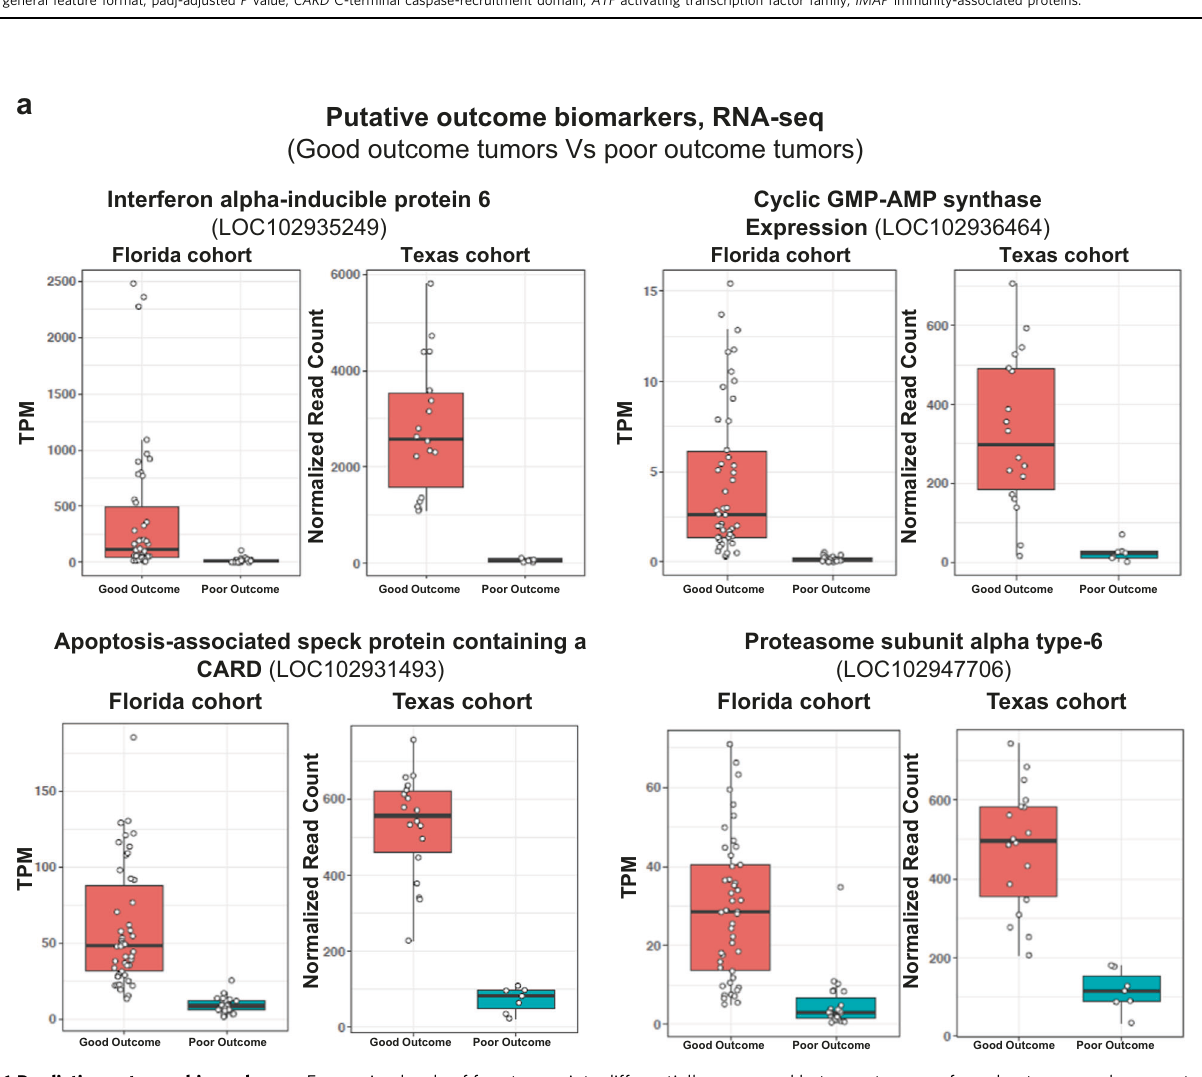
Fig. 6 Predictive outcome biomarkers. a Expression levels of four transcripts differentially expressed between tumors of good outcome and poor-outcome patients, as detected by RNA-seq. Florida cohort: N = 69 samples. Per outcome: released (good outcome) = seven turtles; died/euthanized (poor outcome) = fi ve turtles. Texas cohort: N = 25 samples. Per outcome: prolonged rehabilitation (poor outcome) = two turtles; short rehabilitation (good outcome) = one